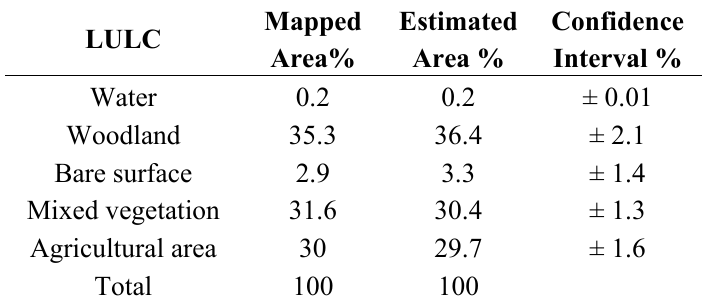
Table 17. Proportion of LULC types in